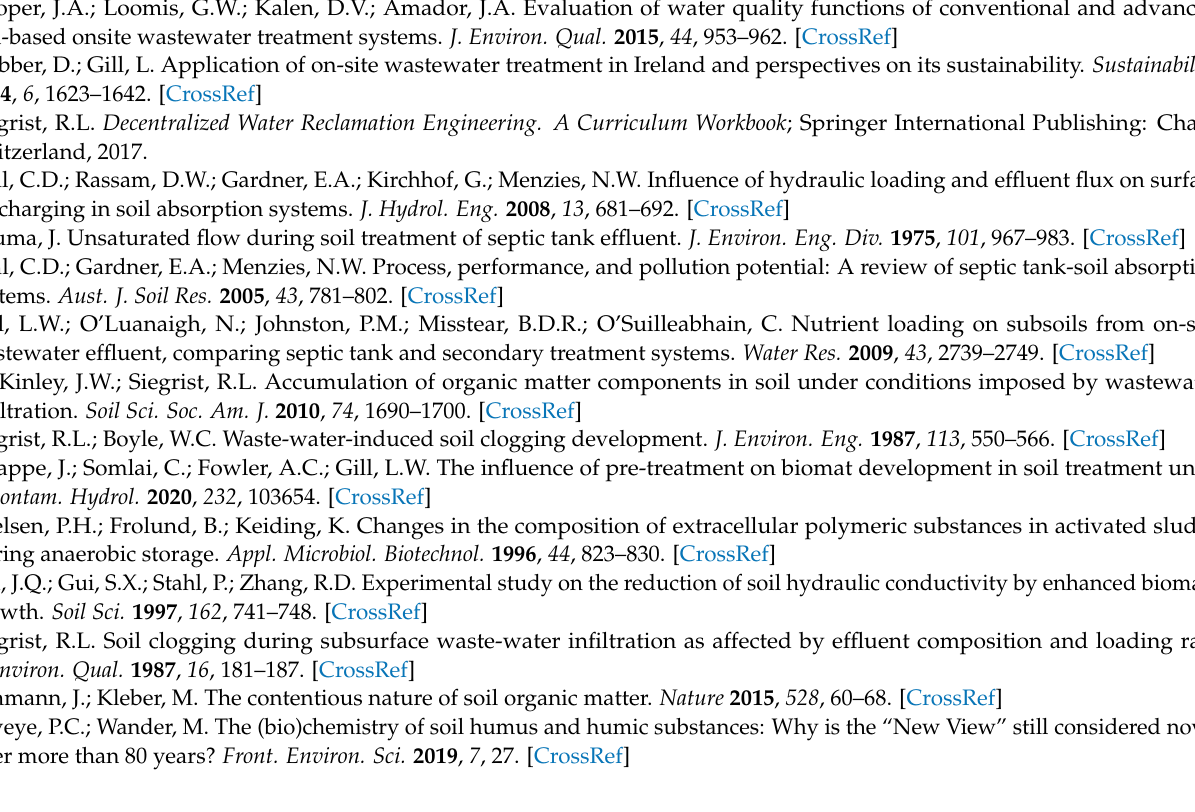
the obtained PARAFAC components (Figure S1: General schematic of soil treatment system, for Sites 1 and 2, Figure S2: Schematic diagram of analytical procedure, Figure S3: Correlation between Humi- fication Index and contributions from each of the six PARAFAC components, Figure S4: Correlation between the proportion of PARAFAC component 2 and results from FWC photodecay